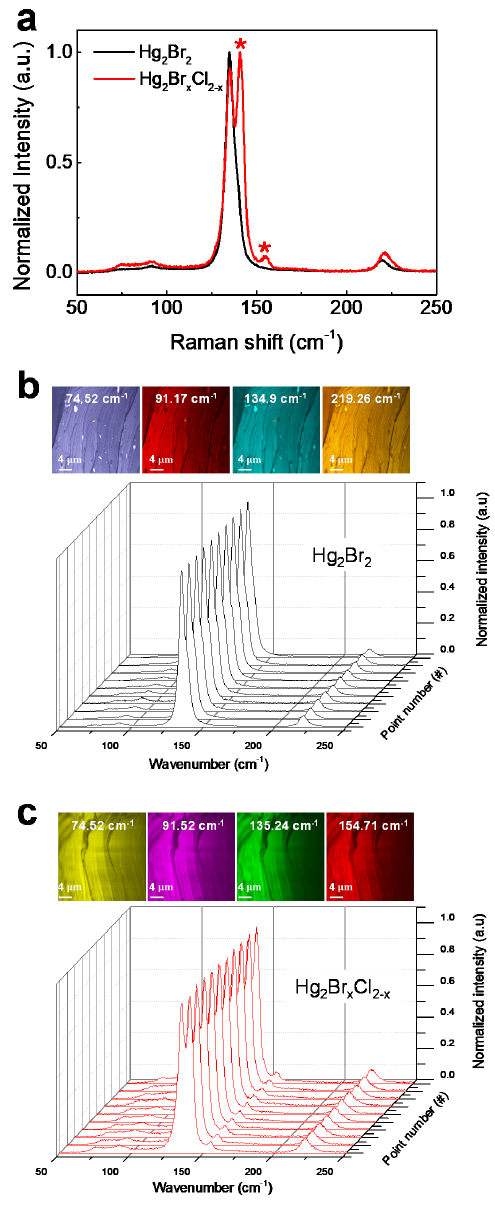
Figure 5. ( a ) Comparison of single point Raman spectra of Hg 2 Br 2 and Hg 2 Br x Cl 2 − x crystals. The major peaks distinguished from Hg 2 Br 2 peaks are marked with asterisks. Raman mapping images and data of ( b ) Hg 2 Br 2 and ( c ) Hg 2 Br x Cl 2 − x with (110) crystal surface plane.